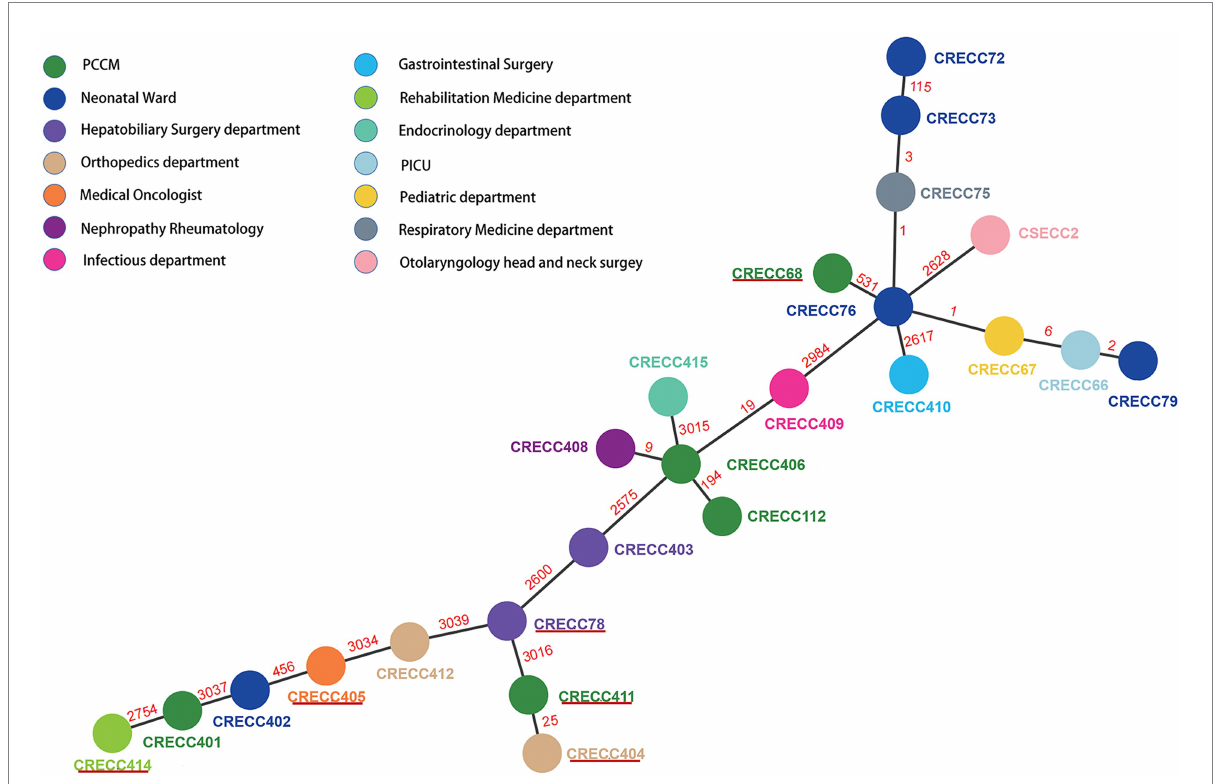
FIGURE 2 Minimum spanning tree for multilocus sequence typing of the core genome based on 3,084 targets. Allelic distances between isolates are represented numerically. The resulting structure reflected the similarity between strains isolated by different departments. Solid red lines represent CRECC strains carrying mcr-9